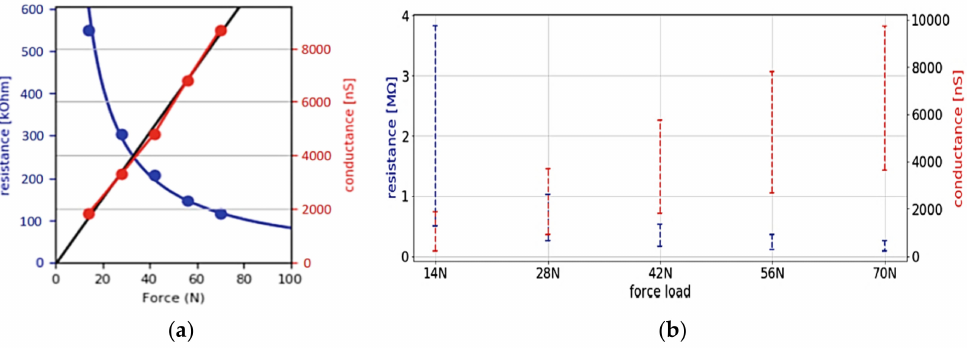
Figure 3. Characteristics of force sensors ( a ); comparison of the force–conductance ranges during calibration of force sensors ( b ) [35], ® by Copyright Clearance Center_Springer Nature_Copyright Permission_Figures 2 and 3.pdf.